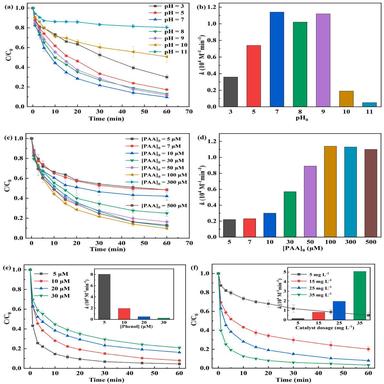
Phenol removal in CPANI/PAA system under different conditions: (a) initial pH and (b) rate constants. Experimental conditions: = 25 mg L− 1 , = 10 μM, = 0.1 mM, initial pH range of 3.0–11.0. (c) Initial PAA concentration and (d) rate constants. Experimental conditions: = 25 mg L− 1 , = 10 μM, = 0.05–0.5 mM, initial pH of 7.0, (e) Initial phenol concentration. Experimental conditions: = 25 mg L− 1 , = 5–30 μM, = 0.1 mM, initial pH of 7.0. (f) CPANI concentration. Experimental conditions: = 5–35 mg